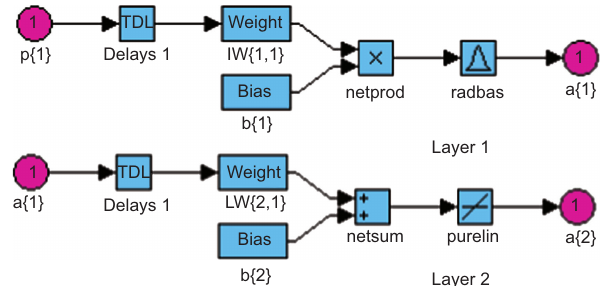
Figure 4. GRNN Architecture [5].